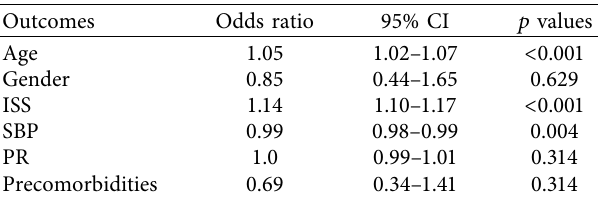
Table 2: Adjusted odds ratio for mortality as a function of